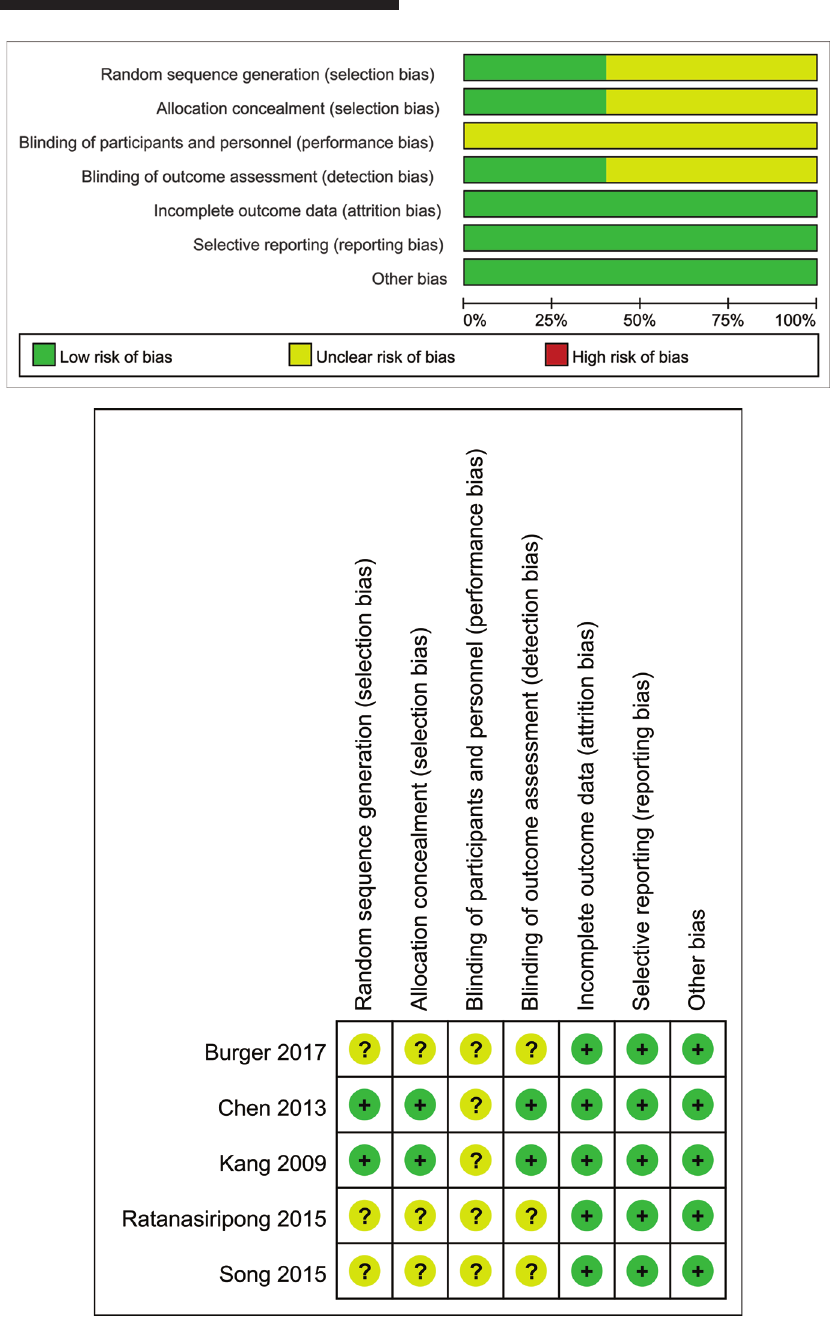
Figure 2. Risk of bias graph and summary of the included studies. A. Risk of bias graph B. Risk of bias